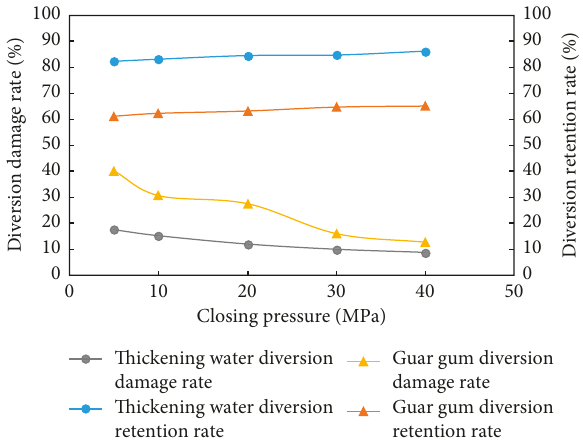
Figure 5: Comparison of diversion retention rate and diversion damage rate of two kinds of fracturing